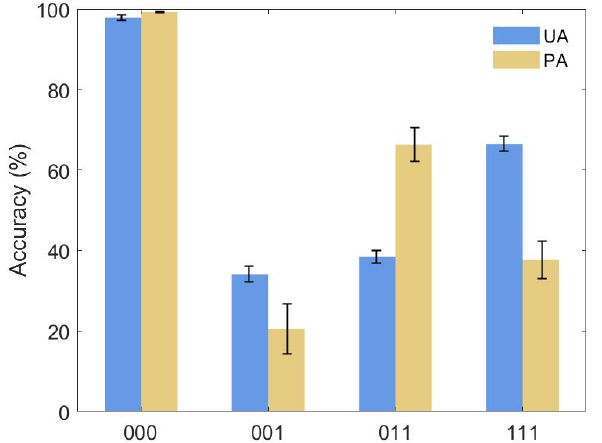
Figure 13. Accuracy estimation for the global three-phase urban land cover for the change and no-change type (000–111 denote the three-phase urban land change and no-change types corresponding to Table 5). OA = 96.9 ± 0.3%.